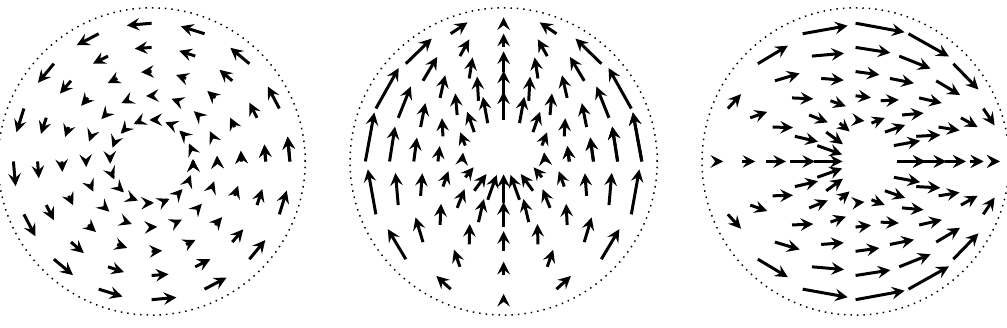
Figure 3. Vector (cid:13)ows of the Euclidean symmetry generators B ( E ) , E ( E ) , and P ( E ) . to compute by placing the center of the circle our point is on at (cid:26) = 0, computing the location of X ? in that coordinate for the given (cid:21) , then performing a boost by E ( E ) to move the segment to its (cid:12)nal position. The result is that (see (cid:12)gure 2 and appendix A